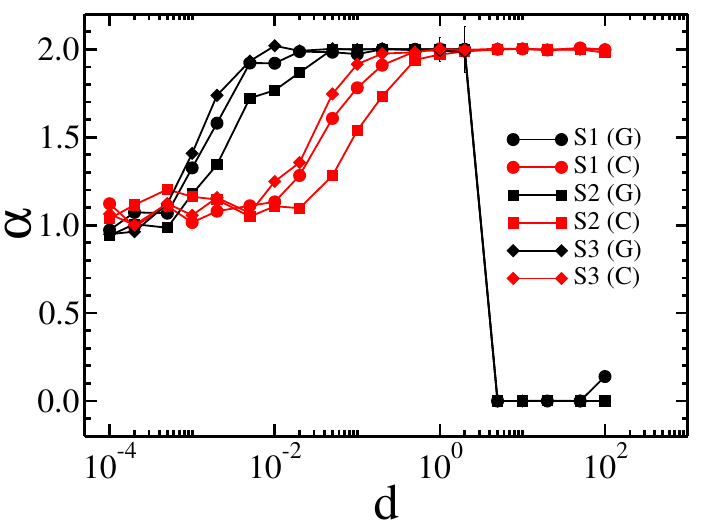
Figure 10. The dependence of the effective diffusion exponent α on the drift d for Gaussian random walks and Lévy flights in the membranes S1, S2, and